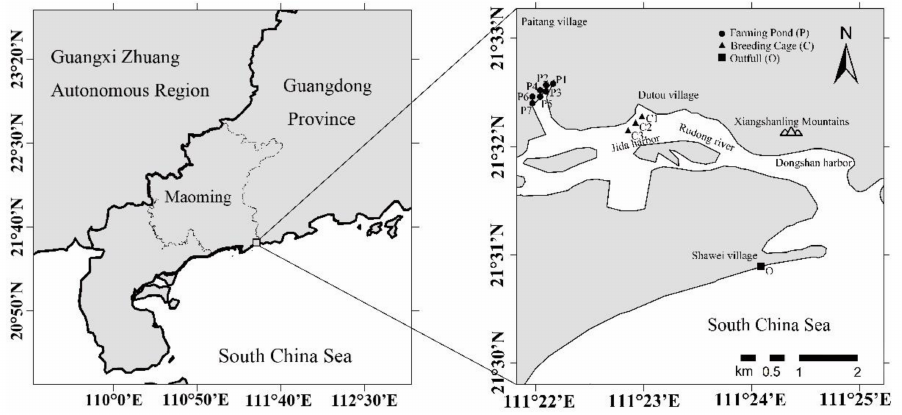
Figure 1. Overview of the study